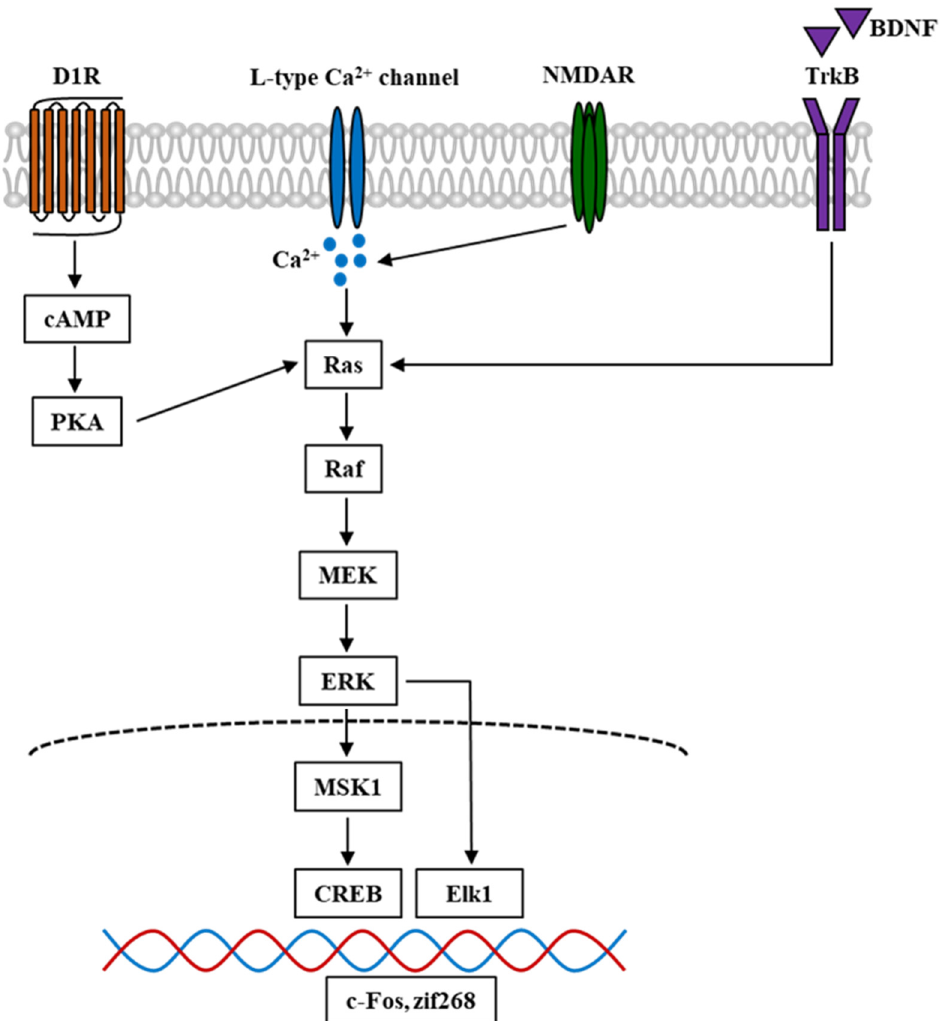
Figure 2. Simplified schematic diagram of ERK signal cascade in the mouse brain involved in psychostimulant-induced addiction. Nicotine and other stimulant drugs activate D1R and facilitate DA release in the DA terminals, leading to PKA and Raf activation. D1R activation causes L-type Ca 2+ channels activation [92], contributing to Ca 2+ influx and elevation of Ca 2+ level, which leads to the activation of Raf. Raf is also activated by Ca 2+ influx through NMDAR, which is mediated by the stimuli of Ras-GRF1 [93], and by BDNF through the binding and activation of TrkB. In turn, Raf activation leads to the phosphorylation and activation of MEK and ERK. The phosphorylation of ERK evokes the activation of downstream targets such as Elk1 and MSK1. The latter could activate and phosphorylate CREB. These transcriptional factors cause the transcription of IGEs such as c-Fos and zif268, which become the underlying mechanism of psychostimulant-induced addiction. D1R, dopamine D1 receptor; DA, dopamine; PKA, protein kinase A; NMDAR, N-methyl-D-aspartate receptor; Ras-GRF1, Ras protein-specific guanine-nucleotide releasing factor; BDNF, brain-derived neurotrophic factor; TrkB, tropomyosin receptor kinase B; MEK, MAPK-ERK kinase; MSK1, mitogen- and stress-stimulated kinase 1; CREB, cAMP response element-binding protein; IGEs, immediate early genes.